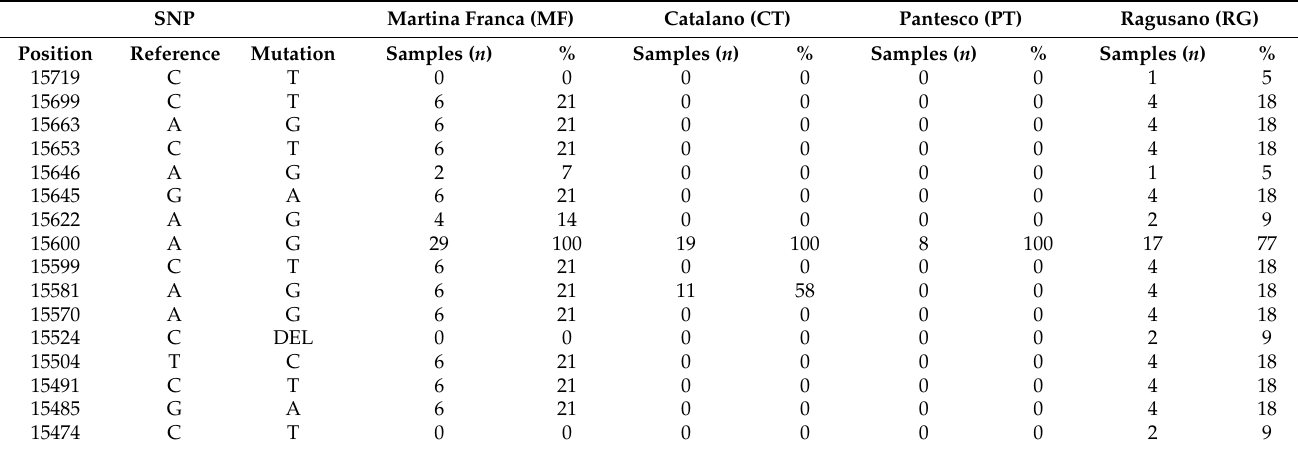
Table 2. Absolute and relative haplotype frequencies in the four analyzed donkey breeds.